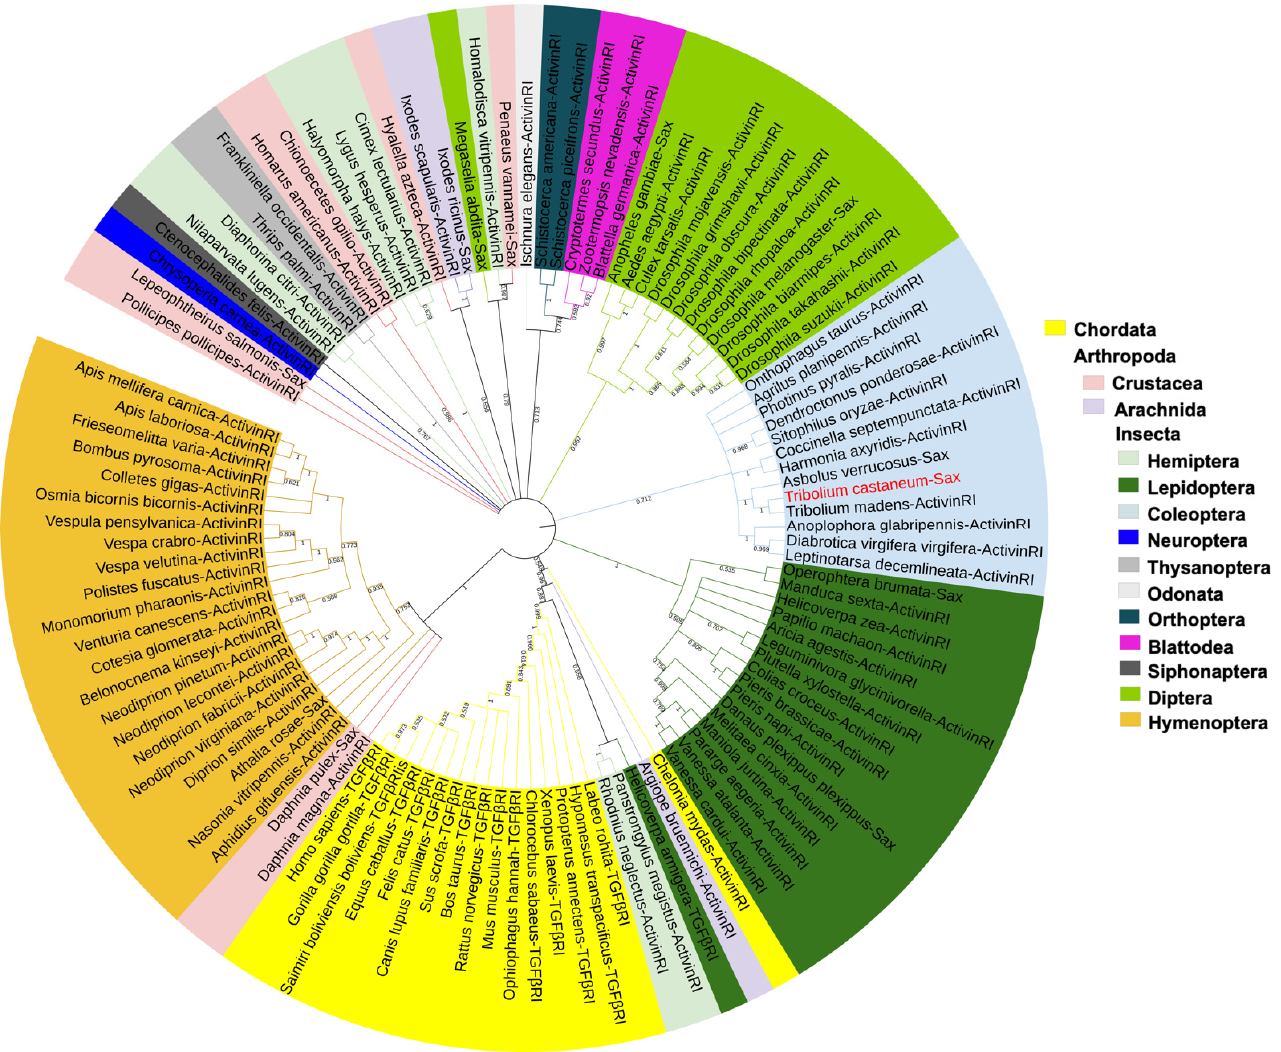
Figure 2. Phylogenetic tree of Sax and other TGF- β superfamily type I receptors (ActivinRI: Activin type I receptor; TGF β RI: TGF- β type I receptor). The phylogenetic tree was constructed using MEGA software XI through the neighbor-joining method with 1000 bootstrap replications. TcSax was marked with red font. The accession numbers of protein sequences used for phylogenetic analysis was shown in Table S2.